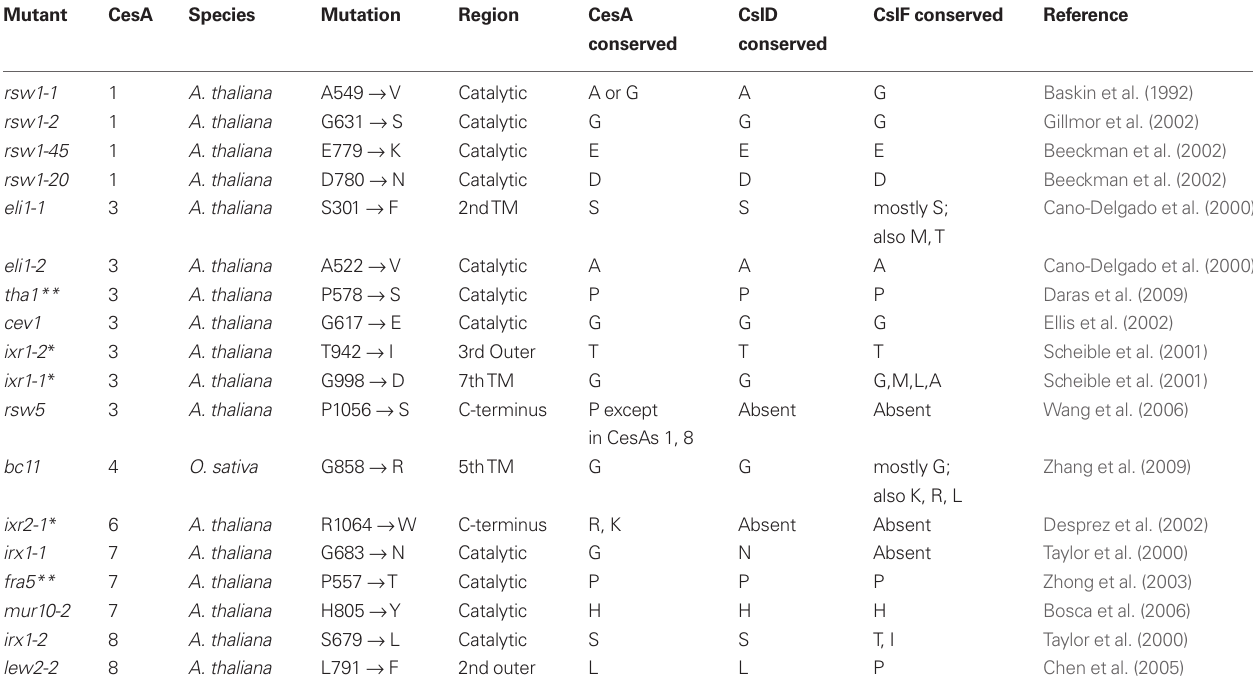
Table 4 | Observed point mutants. Mutant